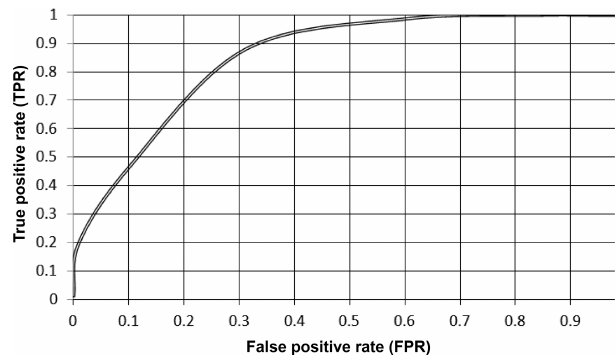
Figure 12. ROC-based accuracy assessment of the landslide sus- ceptibility